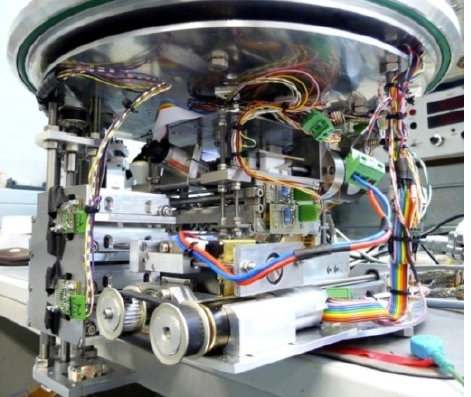
Figure 1. Photographic image of the developed automated system integrated into an evaporation chamber for the production of fiber-based organic electronic